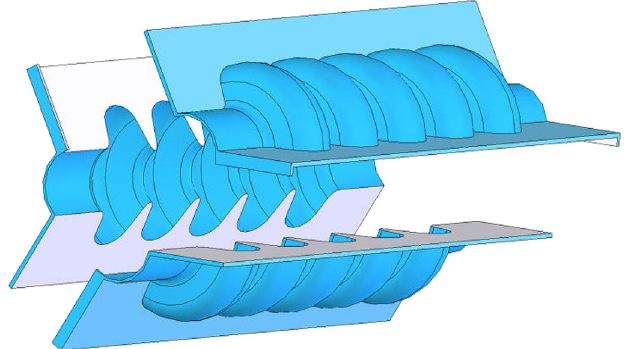
FIG. 2. (Color) Three equal parts of the slotted cavity.